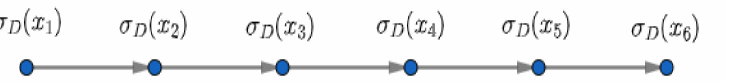
is { σ D ( x 1 ) , σ D ( x 3 ) , σ D ( x 5 ) } and the domination D